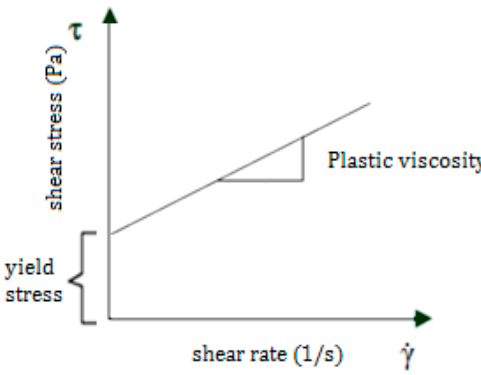
Figure 2. Example of a flow curve of a fluid with yield stress.